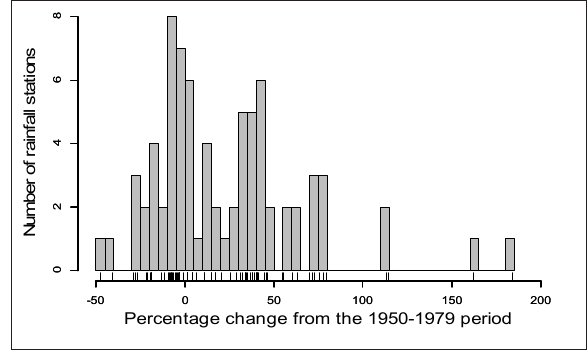
Figure 6: A histogram of the percentage of change return periods at the 95th percentile from the 1950–1979 period for all rainfall stations.